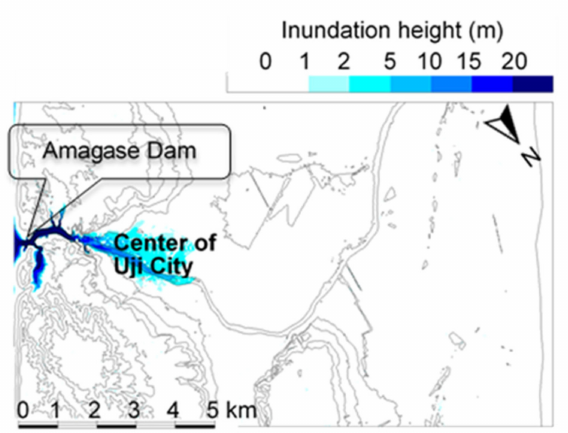
Figure 23. (Case–2). Inundation height, 10 min after start of the calculation.